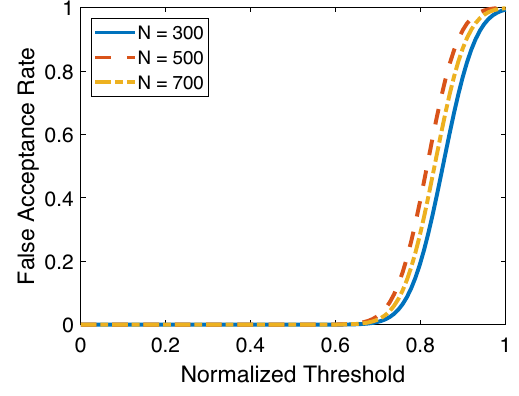
Fig. 5 False acceptance rate for objects out of the sea